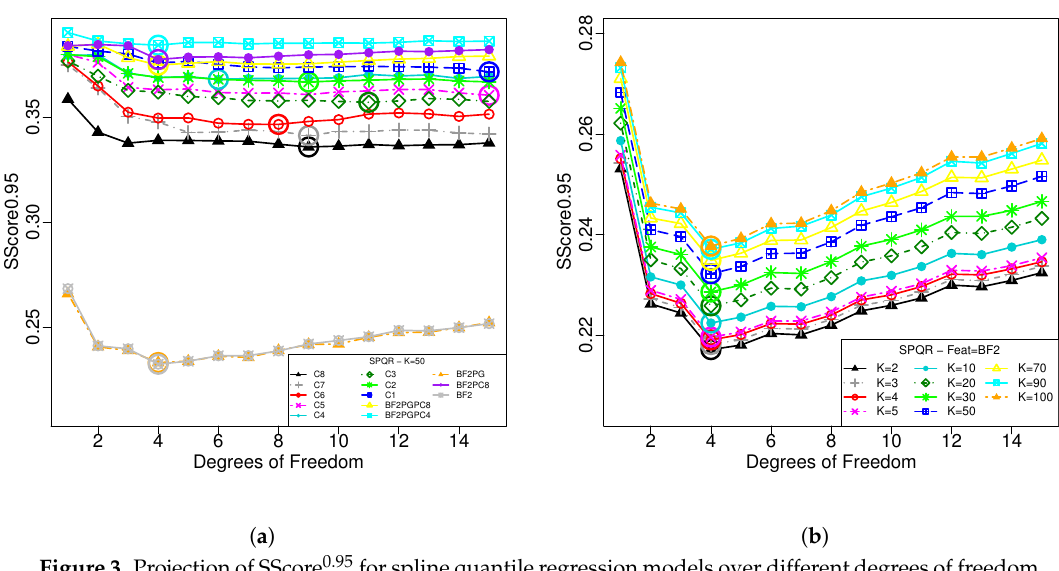
Figure 3. Projection of SScore 0.95 for spline quantile regression models over different degrees of freedom using various feature sets and number of clusters used in skill score uncertainty analysis. ( a ) Feature sets; ( b ) number of clusters used in skill score uncertainty